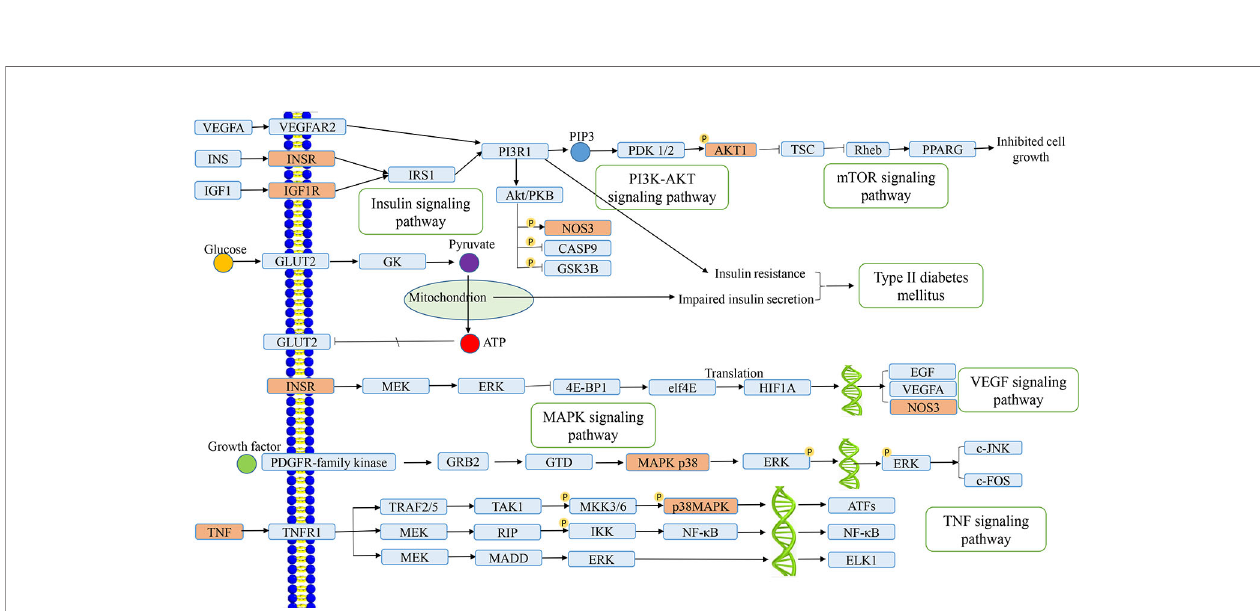
FIGURE 6 | Distribution of the target proteins of Lobelia chinensis on the predicted pathway. The orange nodes are potential target proteins of L. chinensis , while the blue nodes are relevant targets in the